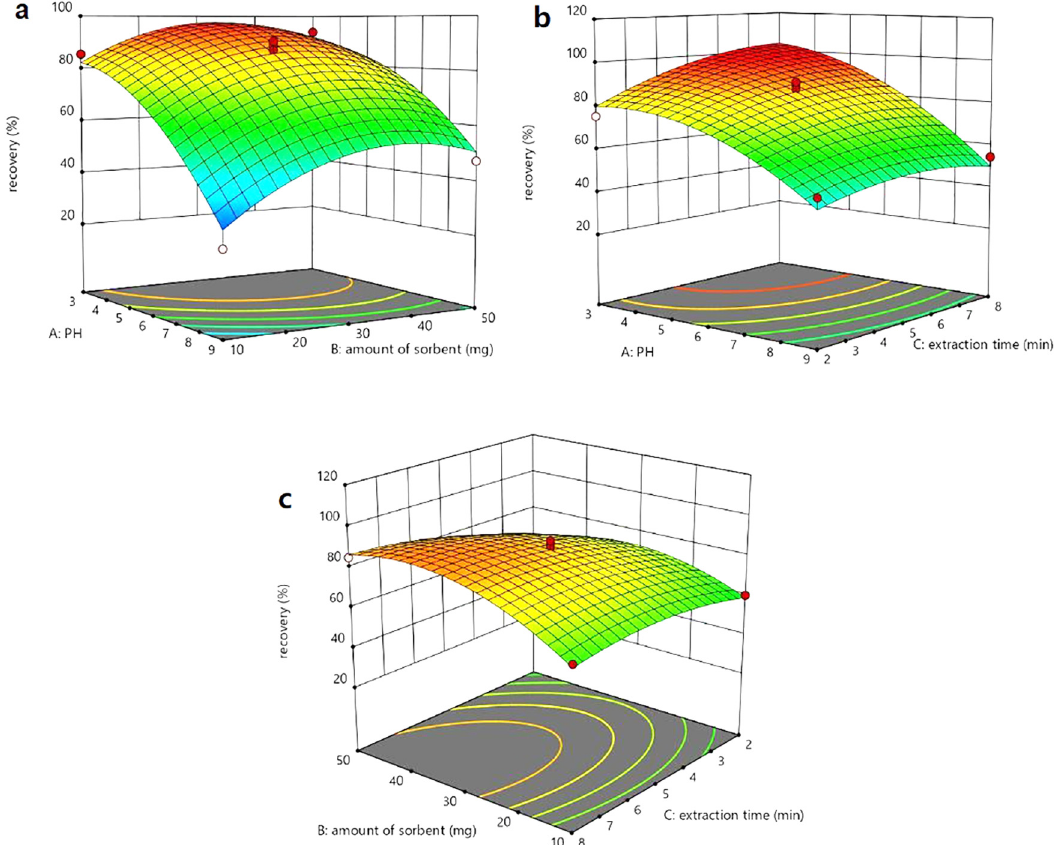
Figure 5: Response surface plots for e ff ect of the MSPE extraction for ( a ) extraction time, ( b ) amount of sorbent, and ( c )